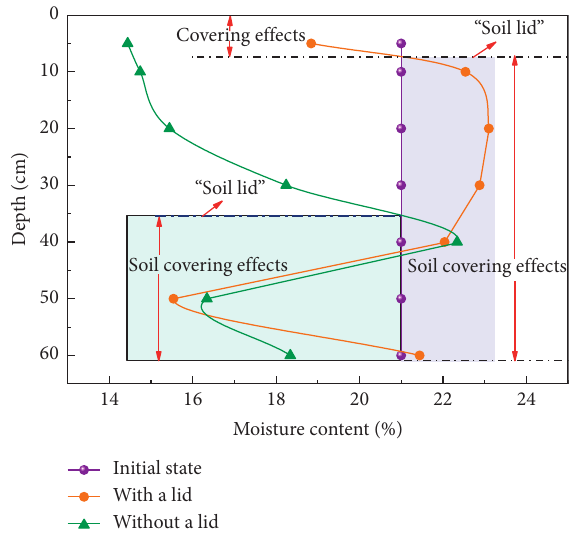
Figure 11: Comparison of moisture content distribution. Figure 10: Moisture content distribution along the depth of the soil